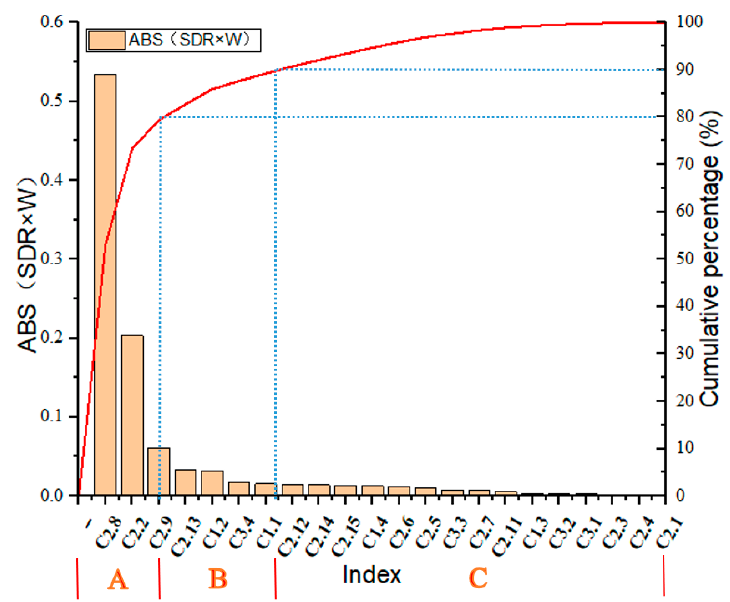
Figure 7. Risk classification chart of the evaluation indices.